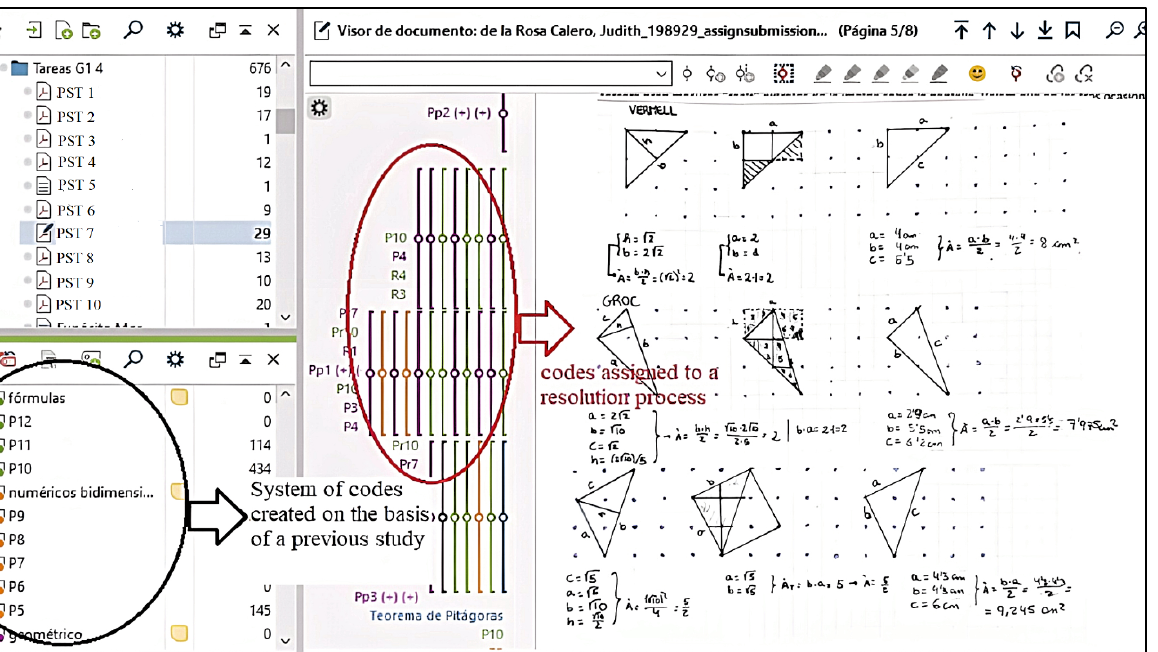
Figure 4. Example of the analysis performed in study 1.